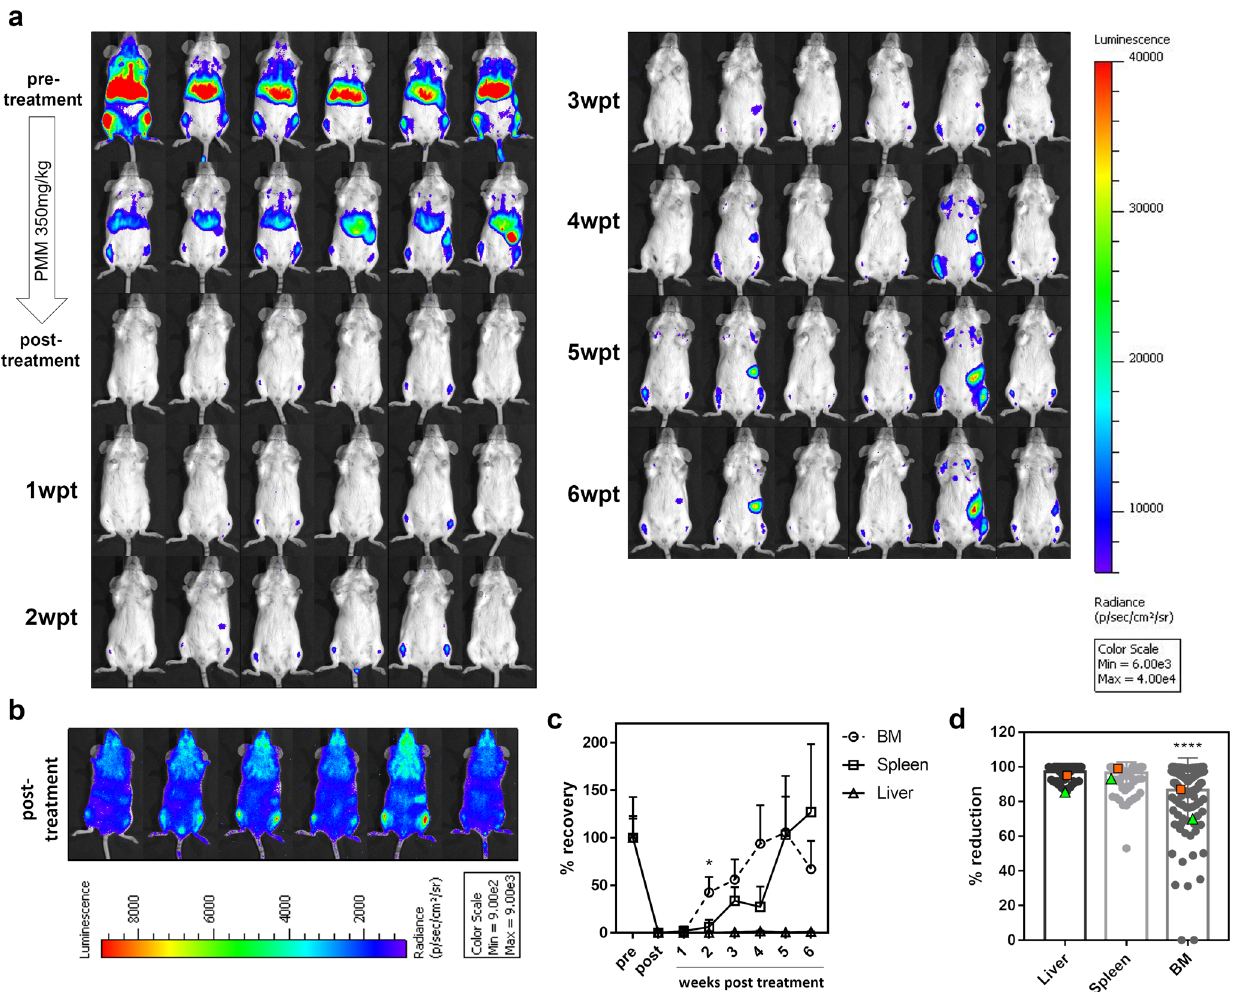
Fig. 1 Reproducible post-treatment relapse model using sub-curative paromomycin identi fi es the BM as niche for treatment failure. a In vivo bioluminescent imaging (BLI) using an exposure time of 15min of LEM3323 WT PpyRE9 infected BALB/c mice at 1-6 weeks post-treatment (wpt) at 350 mg/kg PMM s.i.d. IP for 5 days. b BLI (with sensitivity scale) at the end of treatment. c Mean relative luminescence units (RLU) values of BM and spleen during the fi rst 6 weeks of LEM3323 WT PpyRE9 infection in BALB/c mice, where 100% is the pretreatment RLU and 0% the post-treatment RLU. Results are expressed as mean±SEM, Mann-Whitney test (two-tailed), * p ≤ 0.05. a – c Groups consist of 3-6 BALB/c mice (three independent experiments). d Reduction in parasite burden after treatment of golden Syrian hamsters with a broad set ( n = 90) of antileishmanial test compounds; treatments with >85% clearance in the liver were considered therapeutically relevant. As a reference, squares (orange) depict results with MIL, and triangles (green) represent SSG treatment. Wilcoxon matched-pairs signed rank test (two-tailed), **** p